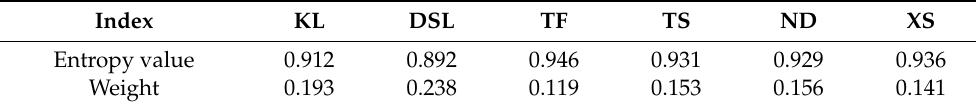
Table 7. Weight of each index based on entropy method.